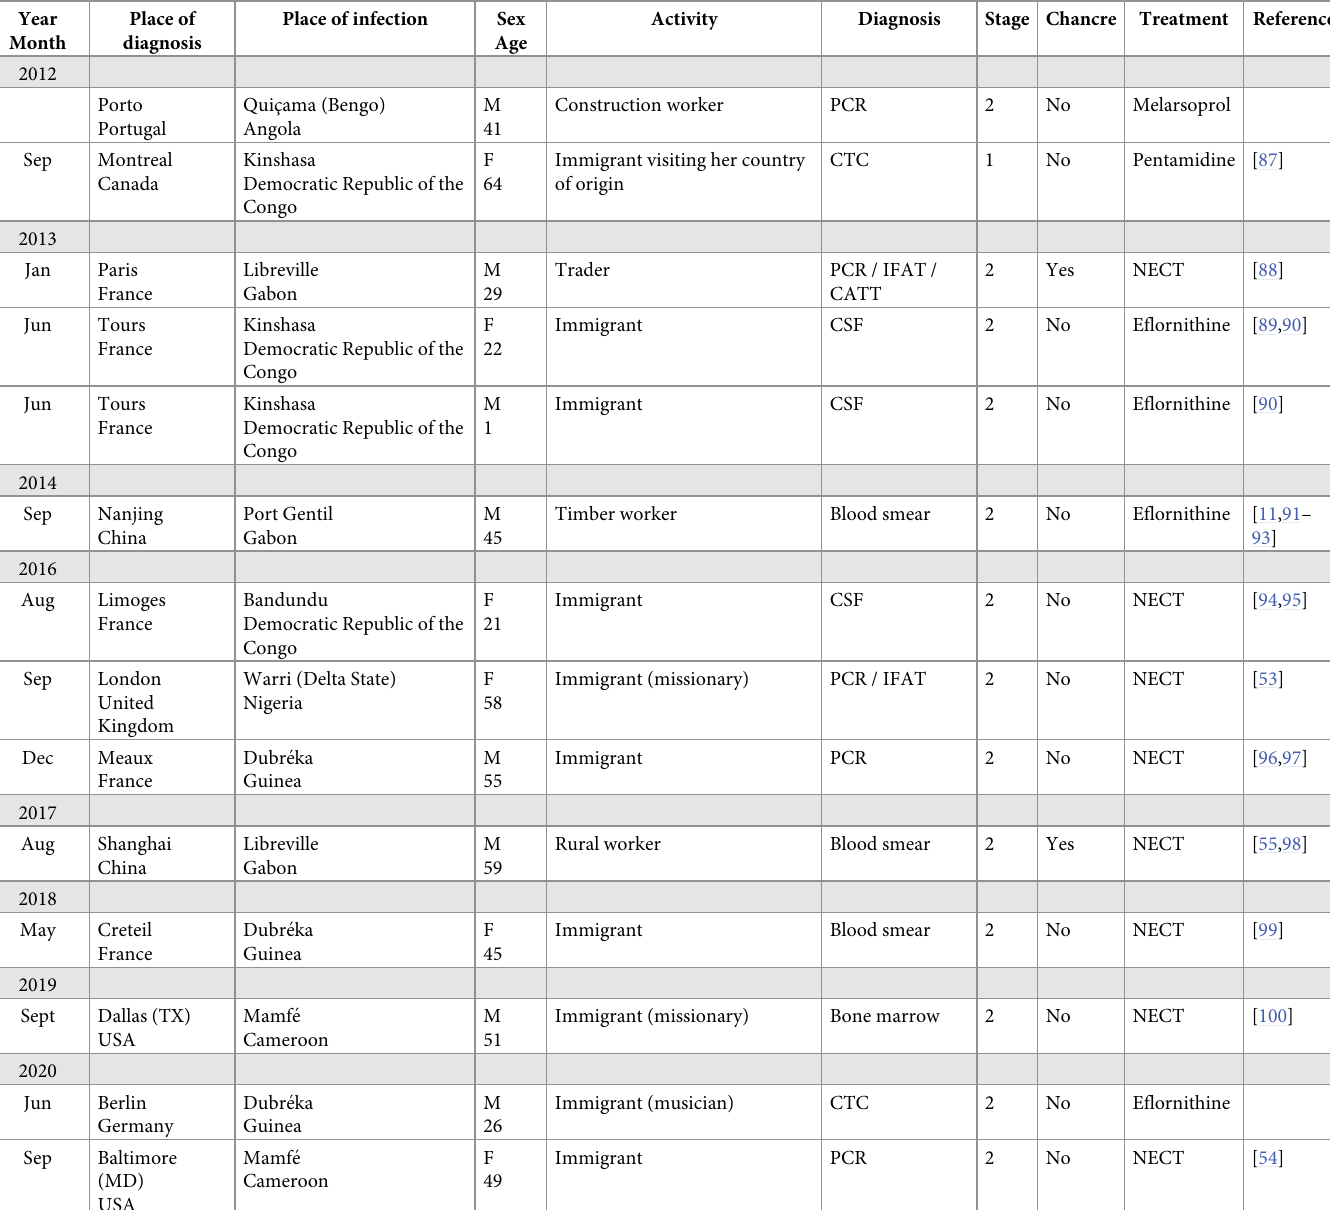
Table 3. Cases of gambiense HAT diagnosed in non-DEC.